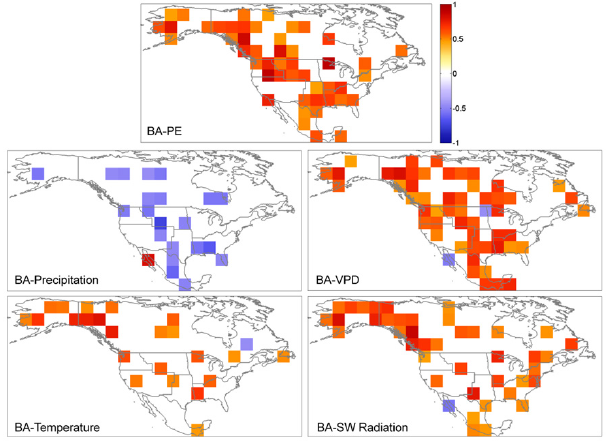
Fig. 5. Pearson’s correlation coefficients for the relationships be- tween GFED BA (1997–2010) during the 3-month fire season and climate metrics for each 5 ◦ × 5 ◦ grid cell in North America. The colour scale indicates the Pearson’s correlation coefficient ( r ). Sep- arate map panels show the correlation between fire-season BA and potential evaporation (PE), precipitation, vapour pressure deficit (VPD), mean monthly temperature, and incoming shortwave short- wave (SW) radiation from reanalysis climate data. Cells without sta- tistically significant correlation coefficients ( p > 0.1) appear